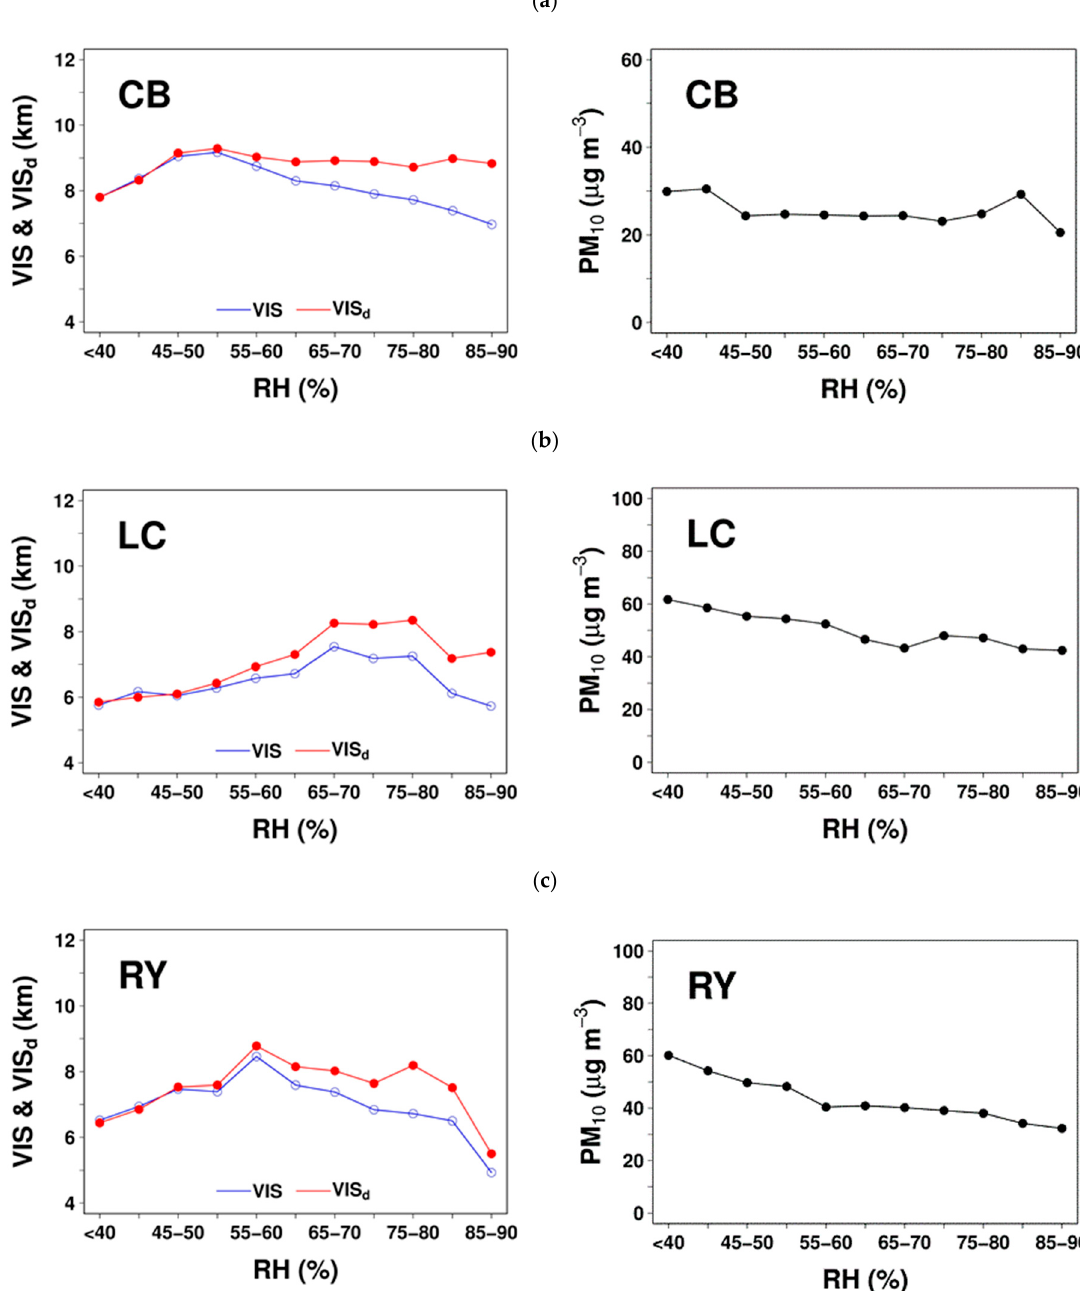
Figure 5. Average visibility, RH -corrected visibility and PM 10 under different RH intervals at ( a ) Chon Buri (CB); ( b ) Laem Chabang (LC); and ( c ) Rayong (RY).